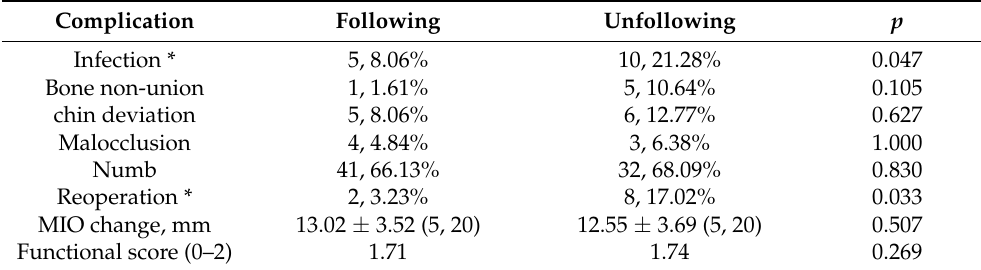
Table 2. Complications of the Two